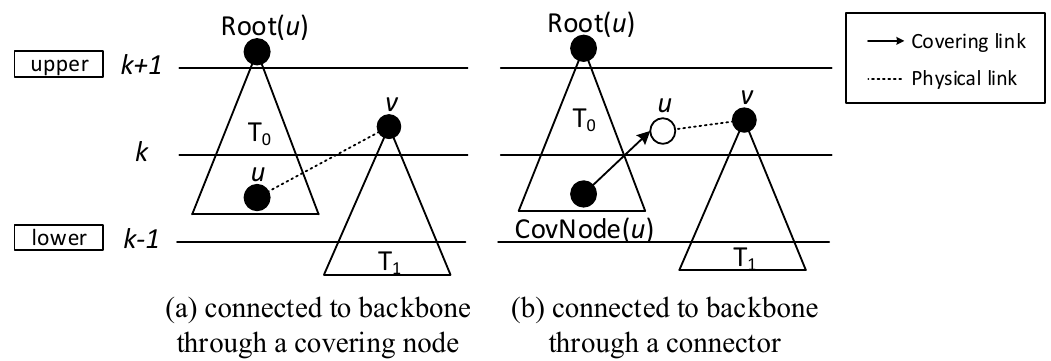
Figure 10. Case 2 in finalizing backbone.